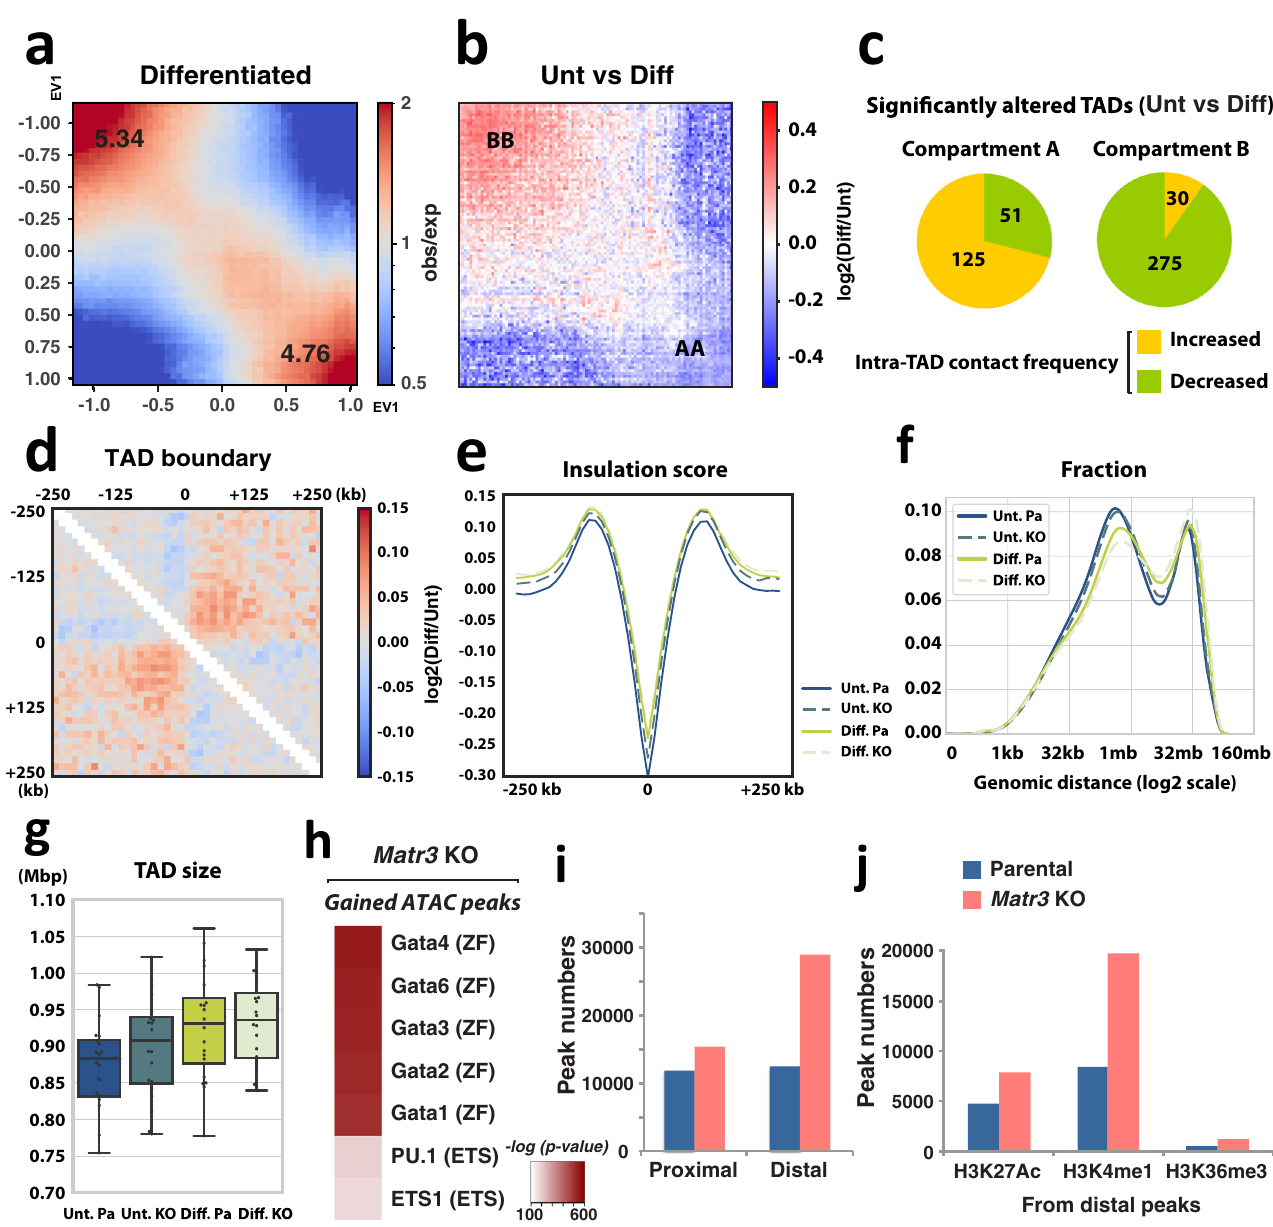
Fig. 3 Alterations of chromatin structure during differentiation resembled that in Matr3 KO cells, and Matr3 loss opens regulatory chromatin regions speci fi c to differentiation. a Contact frequency enrichment for compartment A (bottom right) and B (top left) in the differentiated parental cell. The difference between uninduced (Unt) and differentiated (Diff) cells was calculated as the log2 ratio of average interaction intensity (obs/exp) at 50 kb, and shown as a differential map b and the change was further con fi rmed in Fig. S2b. Results of replicate experiments are shown in Fig. S2d-d ’ . c Analysis of the signi fi cantly altered TADs revealed that most of the TADs during differentiation in compartment A had increased intra-TAD interaction frequency, while those in B had decreased contact frequency. Numbers in the pie chart represent TADs with signi fi cantly changed intra-TAD interaction frequency. d Hi-C interaction data binned at 25 kb resolution was aggregated at TAD boundaries and the difference was calculated by log2 ratio of differentiated and uninduced cells. Results of replicate experiments are shown in Fig. S2e-e ’ . e Average insulation score 29 across TAD boundaries increased during differentiation and in Matr3 KO. Results of replicate experiments are shown in Fig. S2f-f ’ . f Genomic length distribution of Hi-C contacts. Results of replicate experiments are shown in Fig. S2h-h ’ . g Average TAD size for each chromosome identi fi ed using 30 across two independent experiments (Unt.Pa vs. Unt.KO: p = 0.007, Unt.Pa vs. Diff.Pa: p = 0.0004, Diff.Pa vs. Diff.KO: p = 0.46, by two-sided Wilcoxon signed-rank test, respectively; Cohen ’ s d = 0.44, interquartile range of the samples, respectively. h ATAC-seq peaks unique to Matr3 KO compared to parental cells (gained peaks) were used for motif analysis. The natural logarithm of the p-values calculated using the binomial distribution are shown in the heatmap and in Table S1. i The number of ATAC- seq peaks proximal or distal to TSS was counted. Then, the peaks in the distal region were further analyzed to overlap the ChIP-seq peaks for histones j